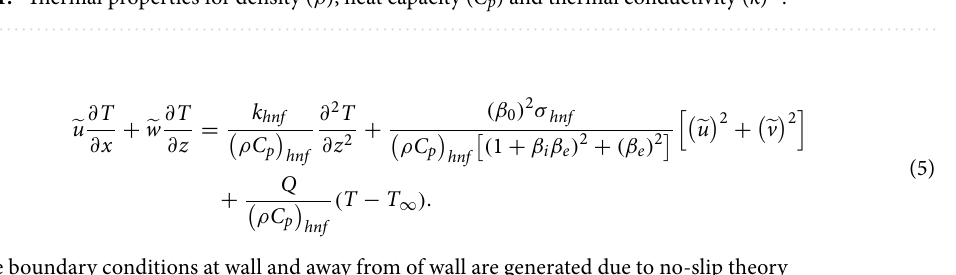
Table 1. Thermal properties for density ( ρ ), heat capacity ( C p ) and thermal conductivity ( k ) 12 .